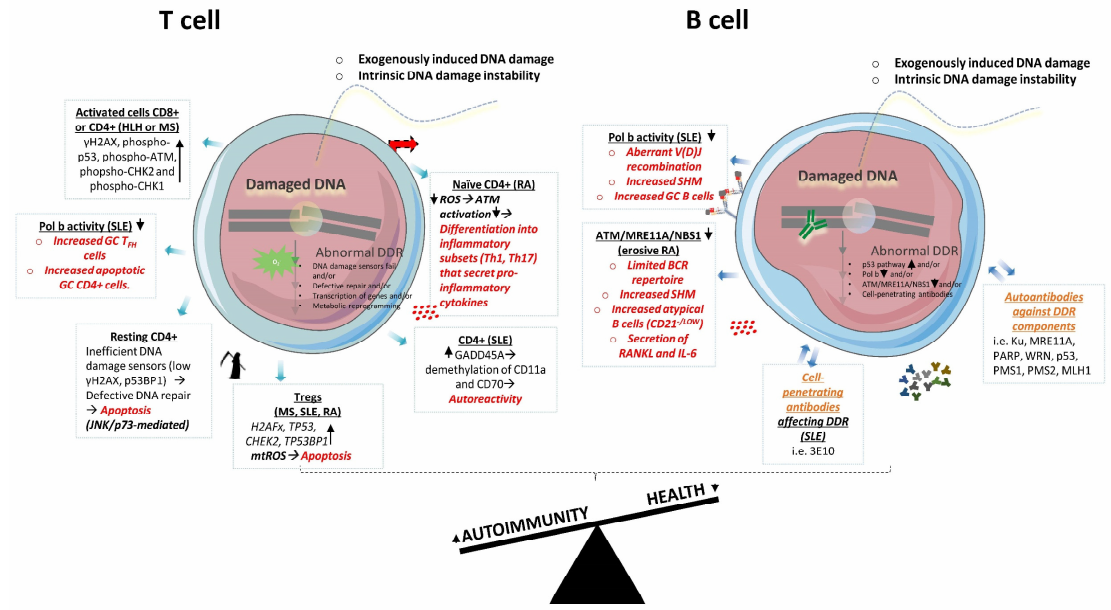
Figure 2. Aberrant DDR in T and B cells in autoimmune states. In autoimmunity, both T and B cells display various defects in DDR molecules, which have been associated with abnormal cellular functions. In autoimmunity, T cells display aberrant expression of DDR genes and proteins, and oxidative stress, which have been associated with alterations in cells’ differentiation into immunogenic subsets and/or increased apoptosis (marked with red color). B cells’ defects in DDR have been associated with aberrancies in V(D)J recombination, SHM, subsets formation and cytokines secretion (marked with red color). In addition, B cells in autoimmunity produce autoantibodies that may enter nucleus and affect DDR (marked with orange color). DDR: DNA damage response; HLH: hemophagocytic lymphohistiocytosis; MS: multiple sclerosis; SLE: systemic lupus erythematosus; RA: rheumatoid arthritis; TFH: T follicular helper; GC: germinal center; ROS: reactive oxygen species; mtROS: mitochondrial reactive oxygen species; Tregs: regulatory T cells; SHM: somatic hypermutation; BCR: B-cell